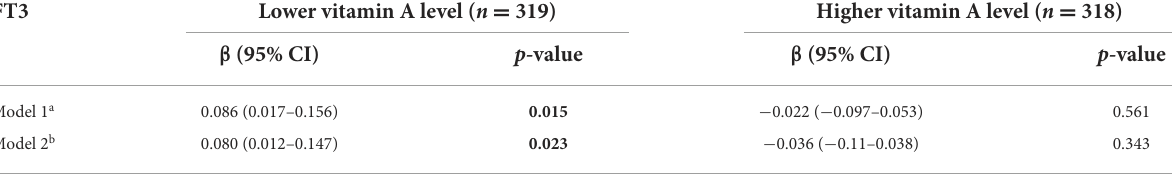
TABLE 4 Associations between maternal FT3 and infant birth weight, stratified by vitamin A level.